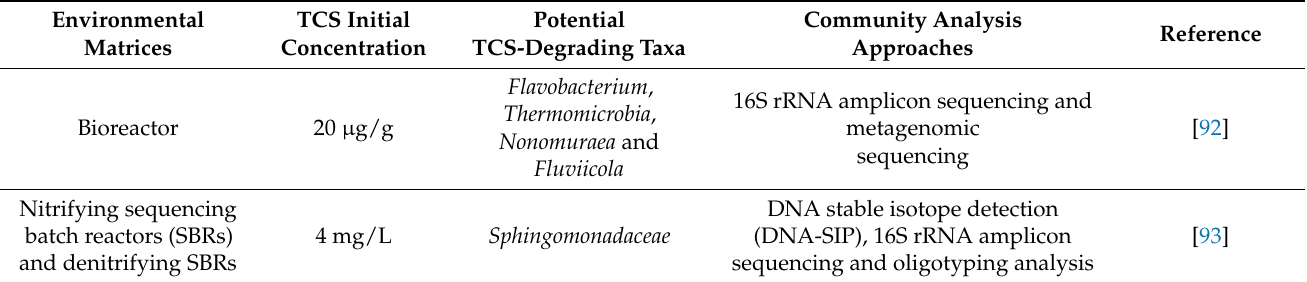
Table 3. Composition of TCS-degrading microbial communities and research